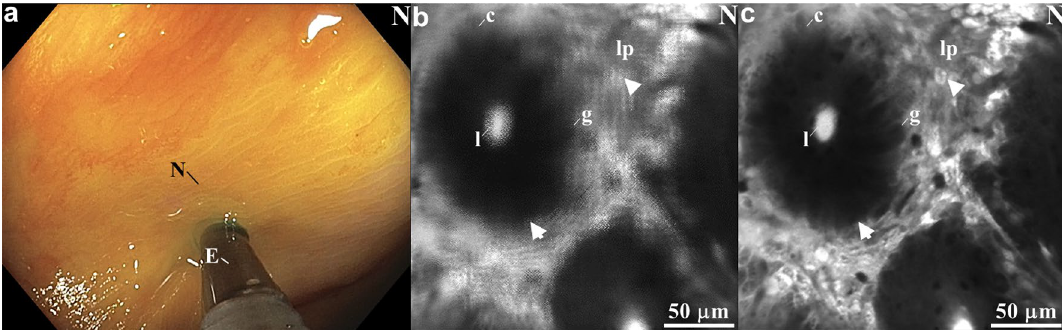
Figure 3. Image processing. ( a ) Wide-field endoscopic image shows endomicroscope (E) placed in contact with normal (N) colonic mucosa for collection of fluorescence images in vivo following administration of fluorescein. ( b ) Drift in phase of the X and Y-axes during scanning may result in blurring from misregistered pixels. Large phase shifts were applied to the original image for demonstration. ( c ) After post-processed phase correction, mucosal details can be appreciated, including crypt structure (arrow) with central lumen (l) surrounded by lamina propria (lp). Individual cells can be distinguished, including colonocytes (c), goblet cells (g), and inflammatory cells (arrowhead). See Supplementary Video 1. ( b, c ) Images were processed using LabVIEW